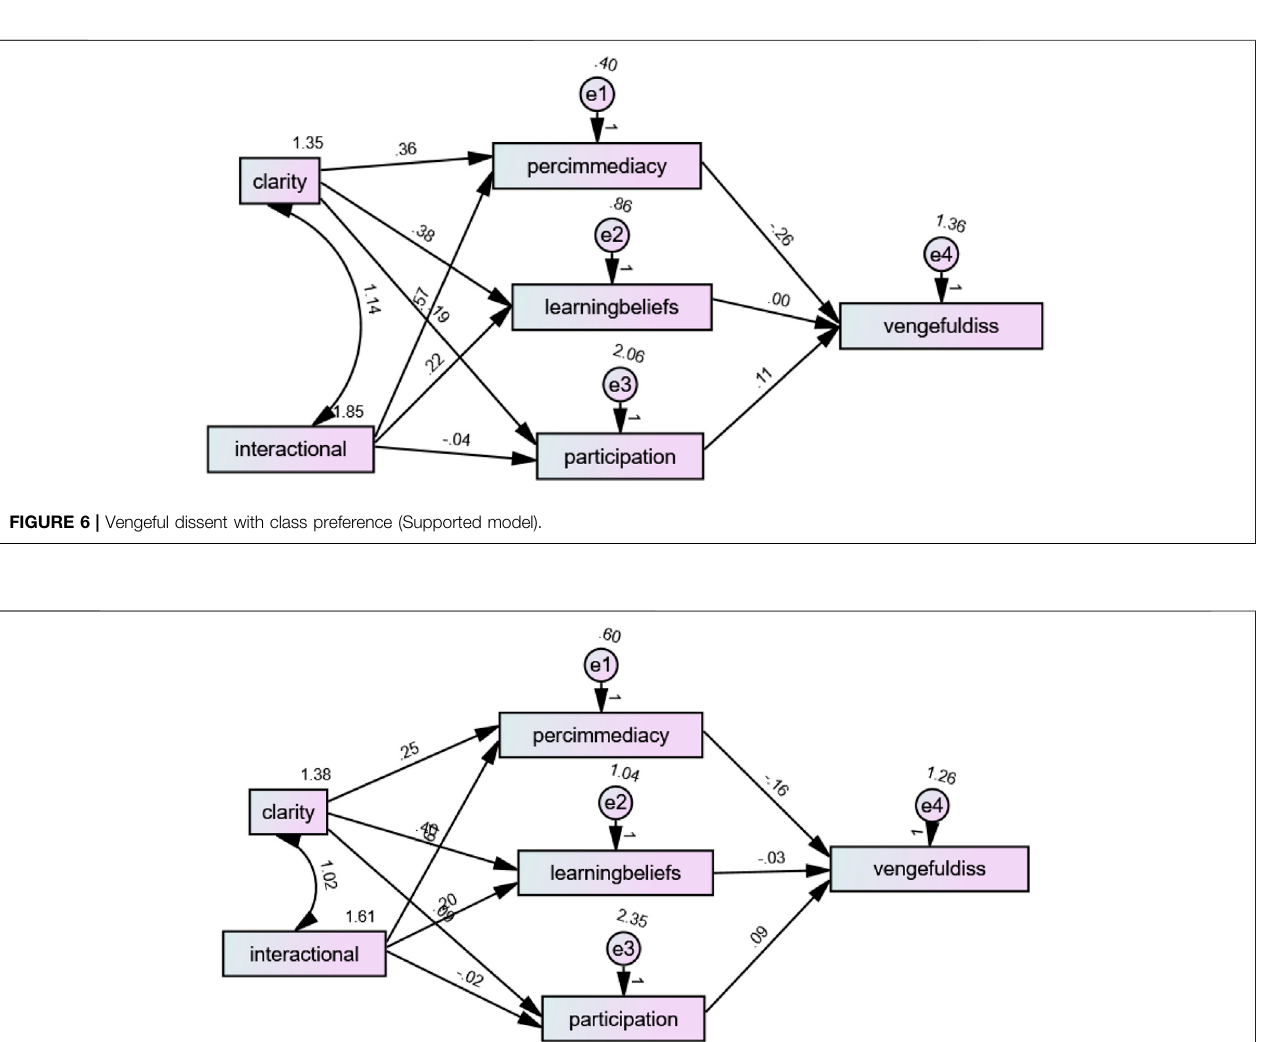
Frontiers in Communication |